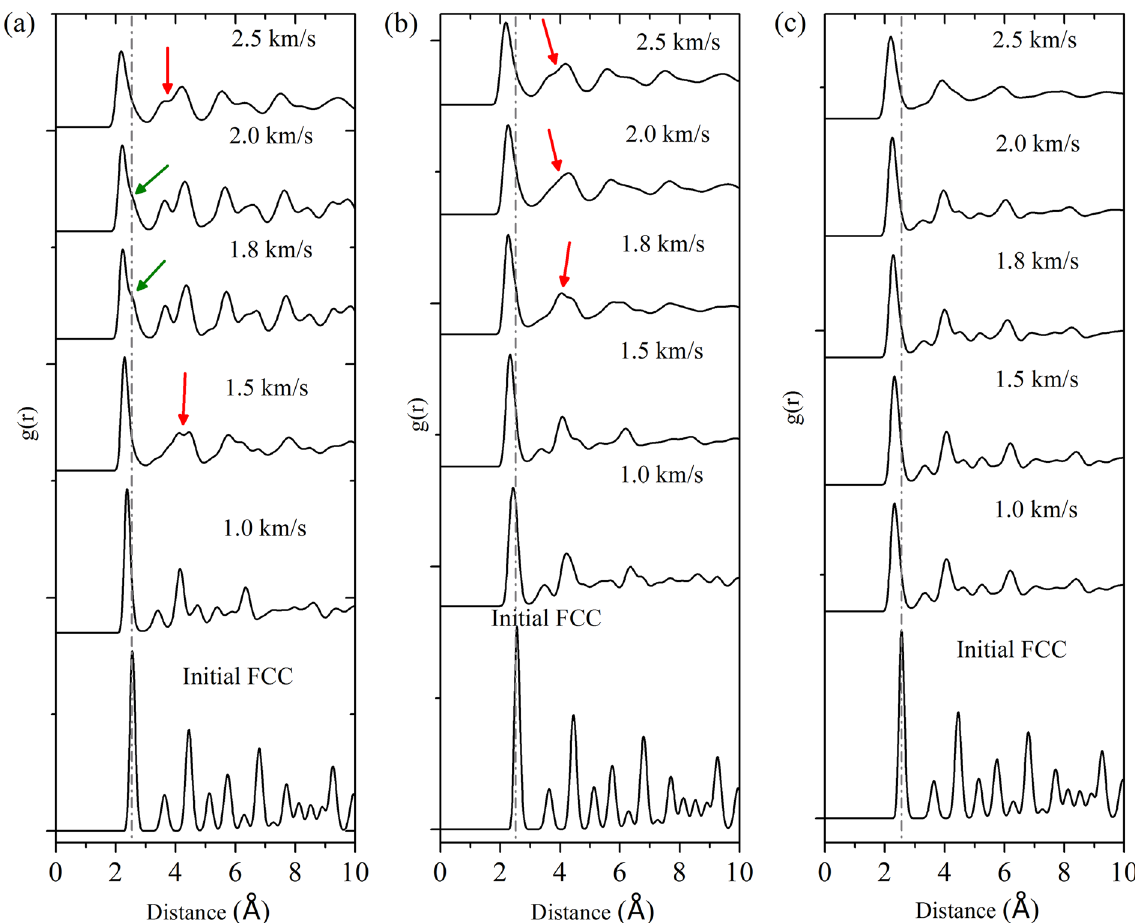
Figure 4. Calculated radial distribution function (RDF) of the deformed micro-structure shocked at a range of impact velocity of 1.0 km/s to 2.5 km/s, along the crystallographic direction ( a ) 〈 100 〉 , ( b ) 〈 110 〉 and ( c ) 〈 111 〉 . In this stacked plots of RDFs, the gray colored dash-dot line represents the shift of the position of the first neighbour with respect to initial undeformed sample. Green arrows indicate the observance of the ‘kink’ like shoulder inflamation region, whereas, red colored arrows point to the ‘wavy’ nature of second neighbour